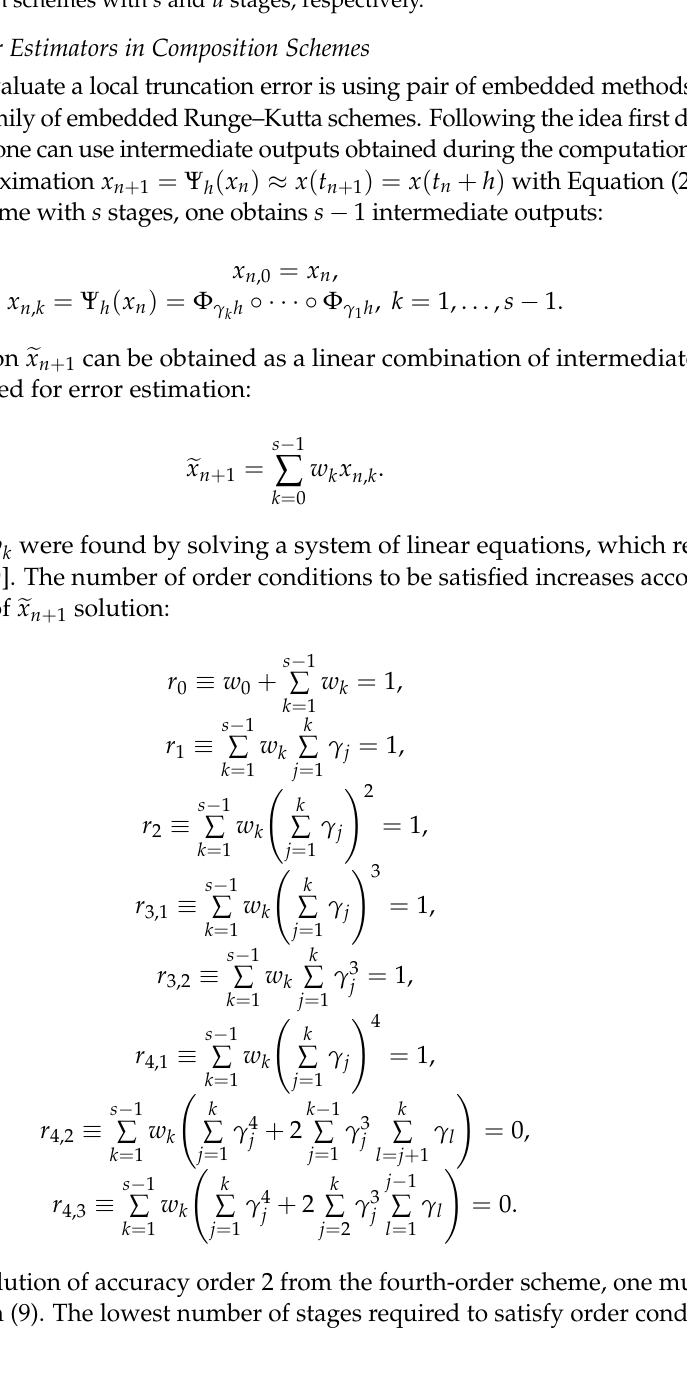
Figure 2. Scheme of DCOM algorithm. 𝛾 𝑘 ,𝑘 = 1,2, …, 𝑠 and 𝛾̃ 𝑘 , 𝑘 = 1,2, … ,𝑢 are coefficients for different composition schemes with 𝑠 and 𝑢 stages, respectively.